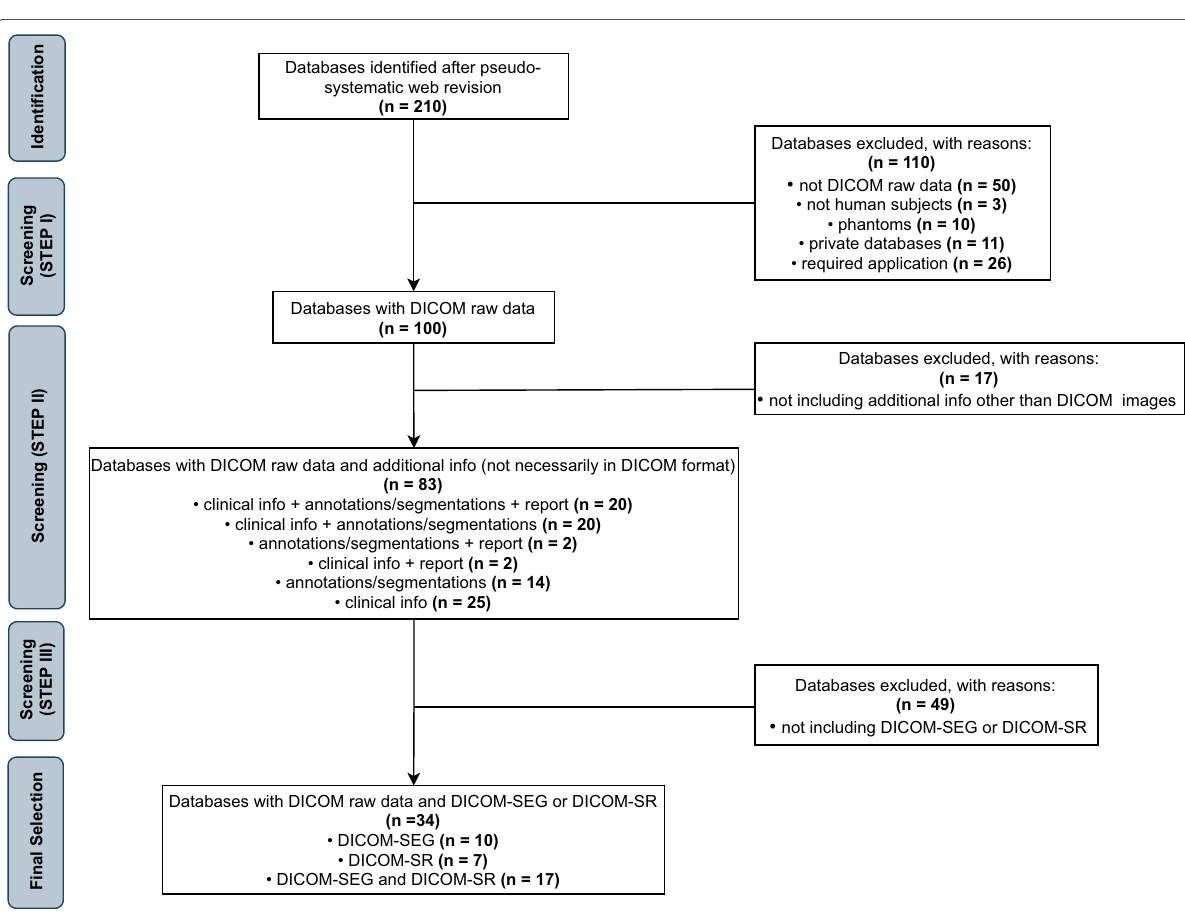
Fig. 3 Flow diagram describing the process of imaging database evaluation and selection. DICOM, Digital Imaging and Communications in Medicine; DICOM-SEG, DICOM segmentation object; DICOM-SR, DICOM structured report